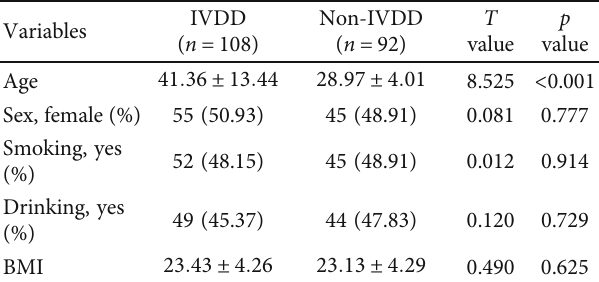
Figure 6: The relationship between the severity of IVDD and the AngII level in the peripheral blood. (a) The MRI results of non- degenerated patients and degenerated patients. (b) The level of AngII in peripheral blood of patients in the two groups. (c) Correlation analysis between AngII level in peripheral blood and the severity of IVDD. (d) The ROC curve analysis was used to test the ability of the AngII level to predict the risk of IVDD. Table 4: Characteristics of the participants involved in exploring the relationship between IVDD and